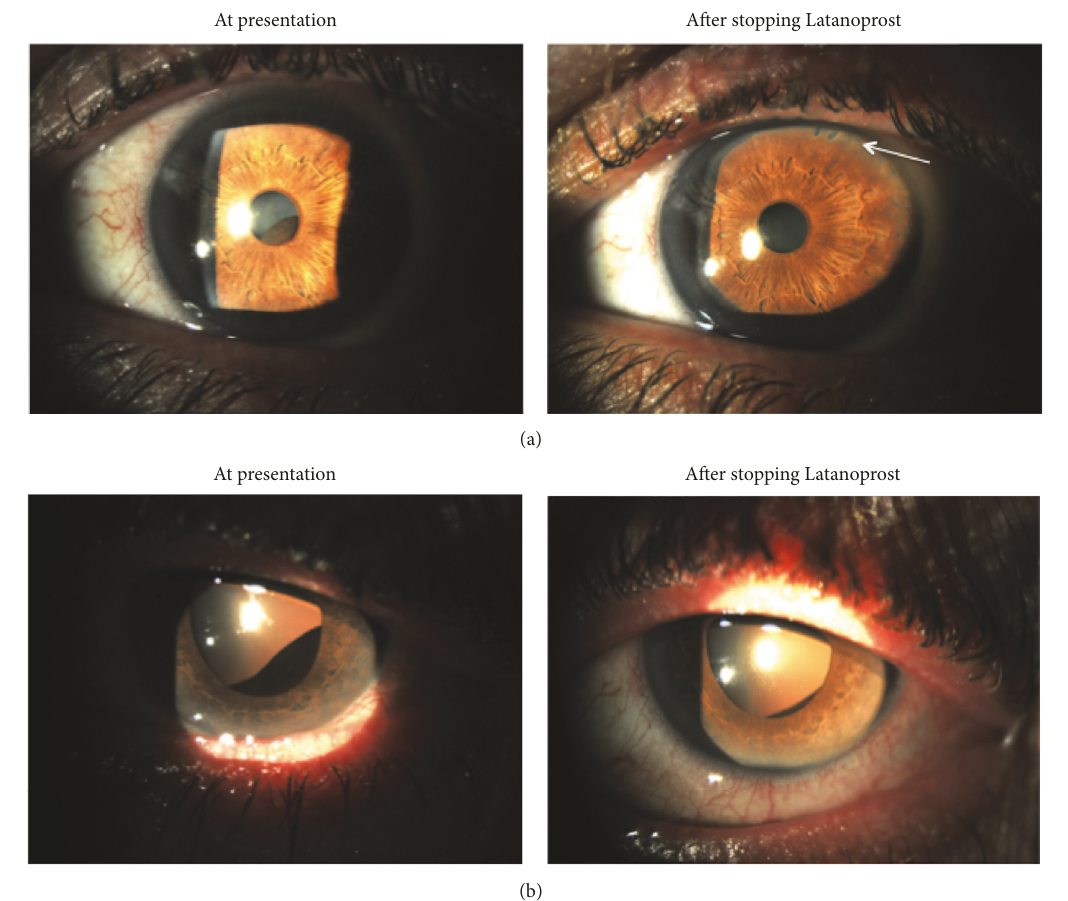
Figure1:(a)Predilationand(b)postdilationanteriorsegmentphotosoflefteyeshowinglargeinferotemporaliriscystatpresentation,causing ectropion uveae and anterior displacement of the iris surface. Four months after stopping topical Latanoprost, the cyst is only evident after dilation. Note patent peripheral iridotomies